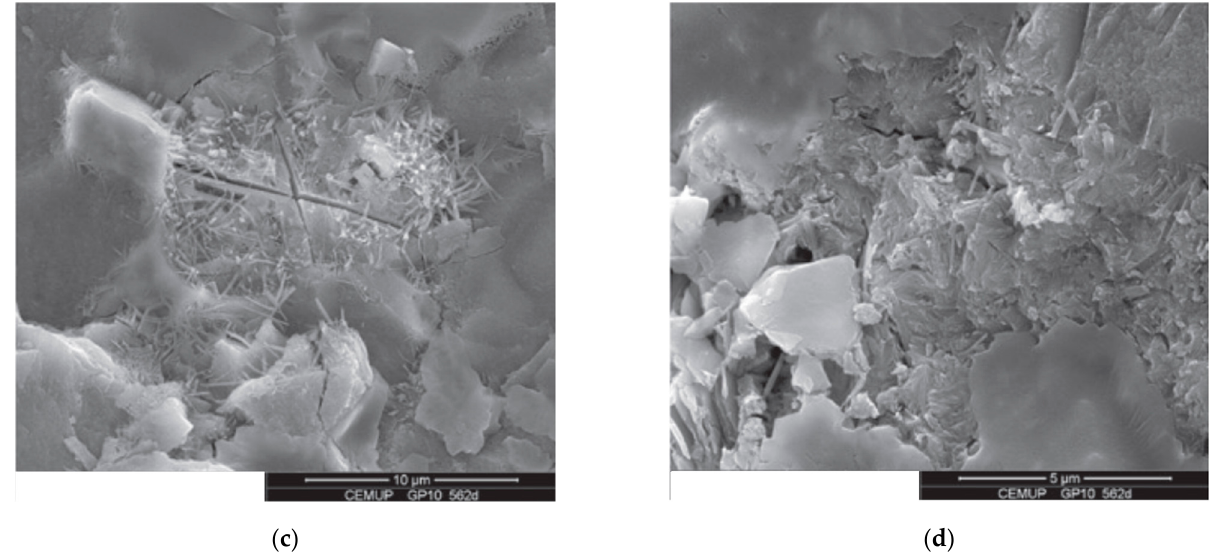
Figure 18. Microstructure of composites: ( a ) control mix, 10,000 times enlarged; ( b ) control mix, 20,000 times enlarged; ( c ) containing 10% waste glass powder, 10,000 times enlarged; ( d ) containing 10% waste glass powder, 20,000 times enlarged [108].